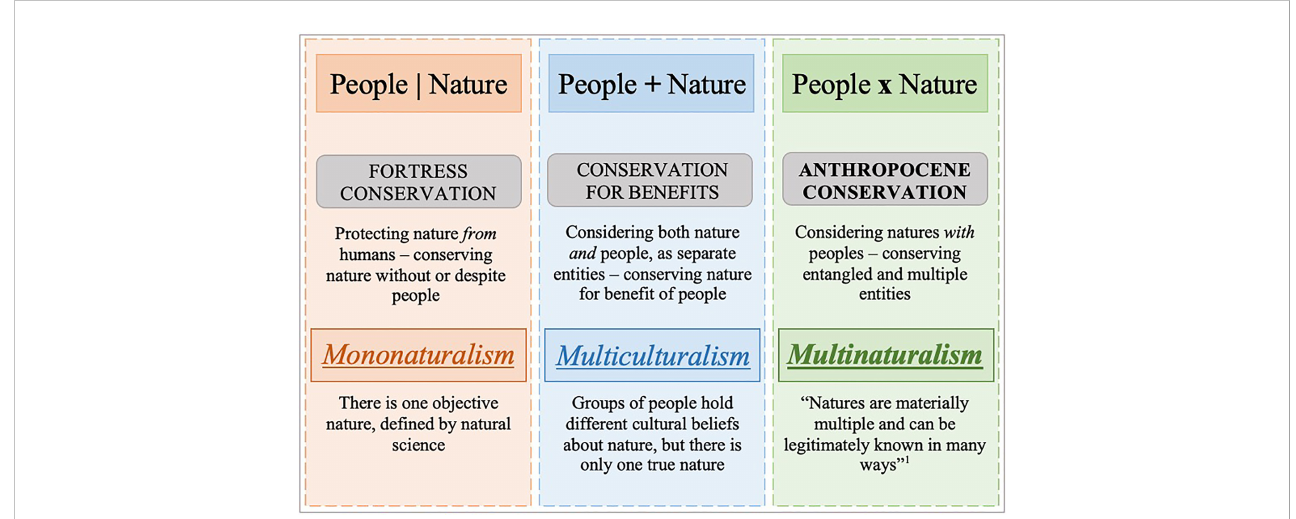
FIGURE 1 From mono to multinaturalism: Frameworks for conservation. 1 Lorimer, 2015,